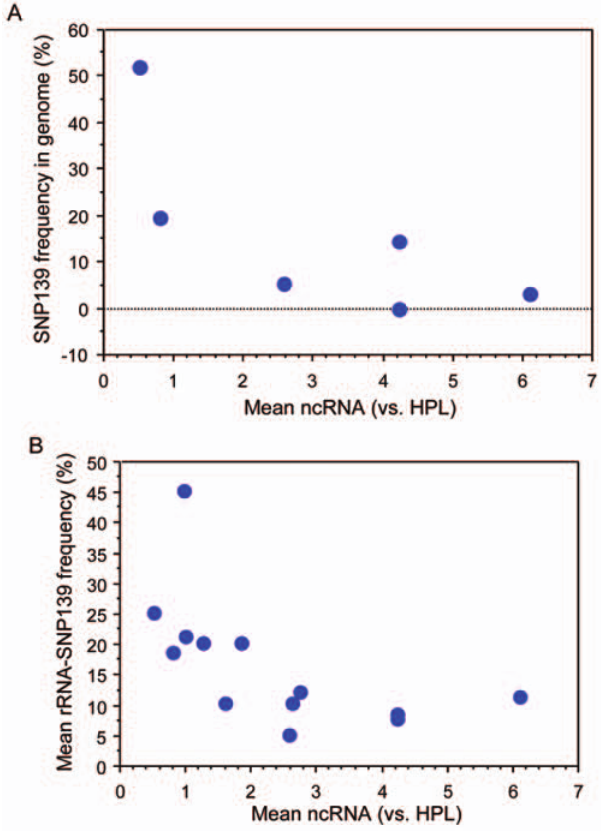
Figure 5. Correlation of average levels of nc-rRNA (relative to HPL cells) with frequency of the SNP at + 139. A. Correlation of the genomic SNP determined by cloning in 6 human lung cancer cell lines, A549, H441, H23, H1792, H2030, and H2122 (see Table 2) (Spearman rank correlation coefficient, rho= 2 0.89, P=0.0409, by the Spearman rank test). B. Correlation of the SNP as variant rRNA transcript in 13 cancer lines (Spearman rank correlation coefficient, rho= 2 0.71, P=0.0137, by the Spearman rank test).